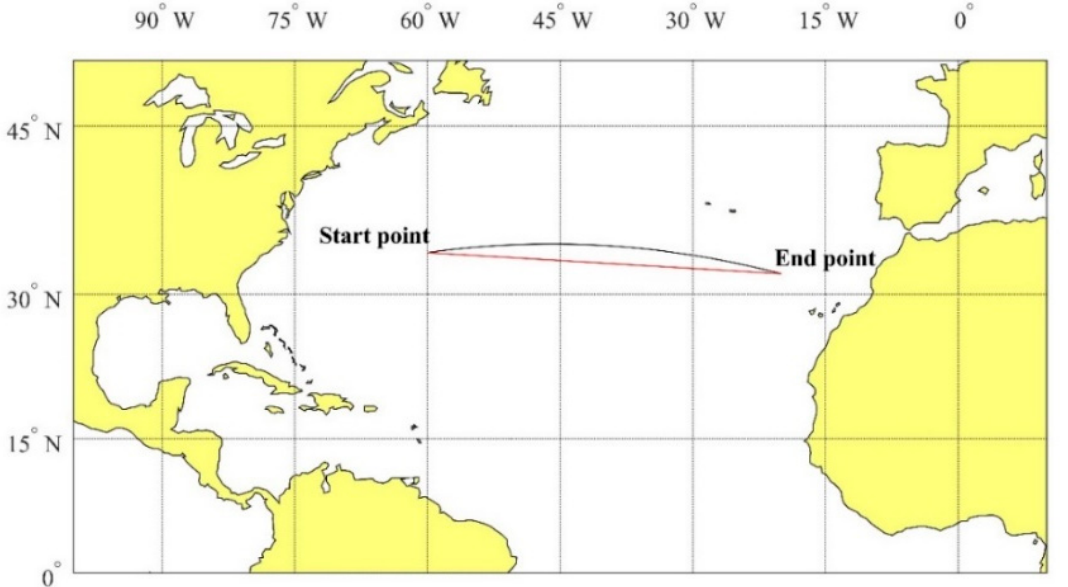
Figure 2. Great circle (black) and rhumb-line (red) between routes’ departure and arrival points.